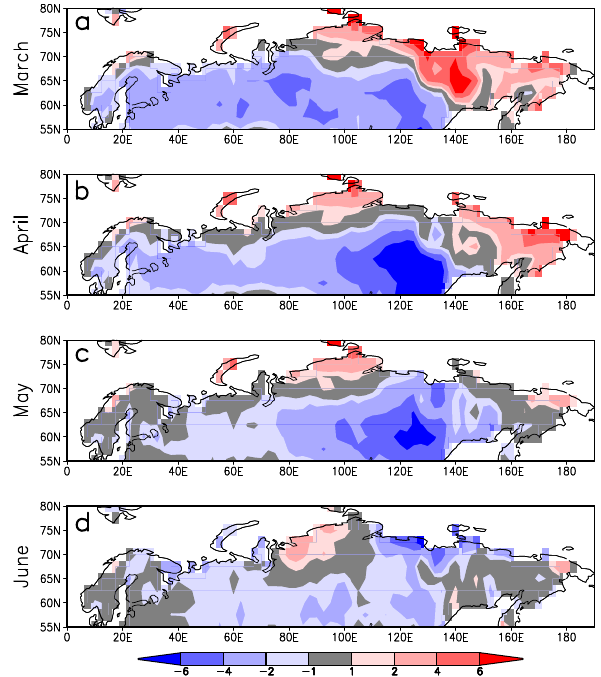
Figure 5. Differences in 2m air temperature [K] for years 1979– 2006 between the REF experiment and the CRUTEM3 data set for the months of March, April, May and